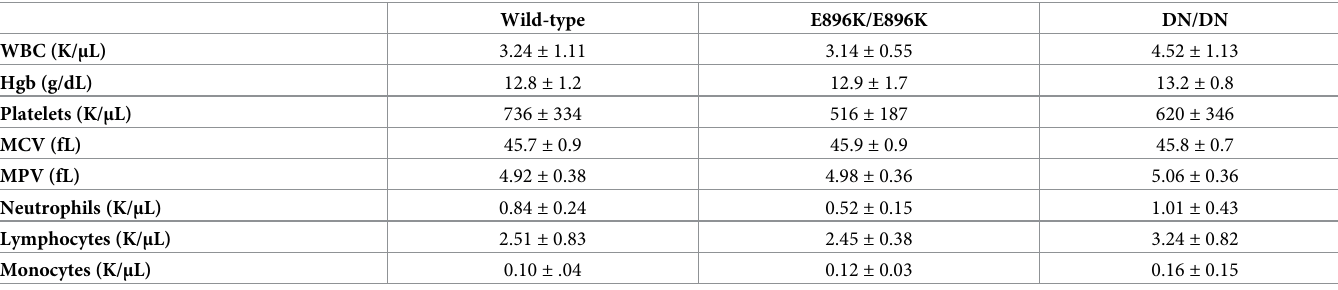
Table 2. Blood count values by Trpc6